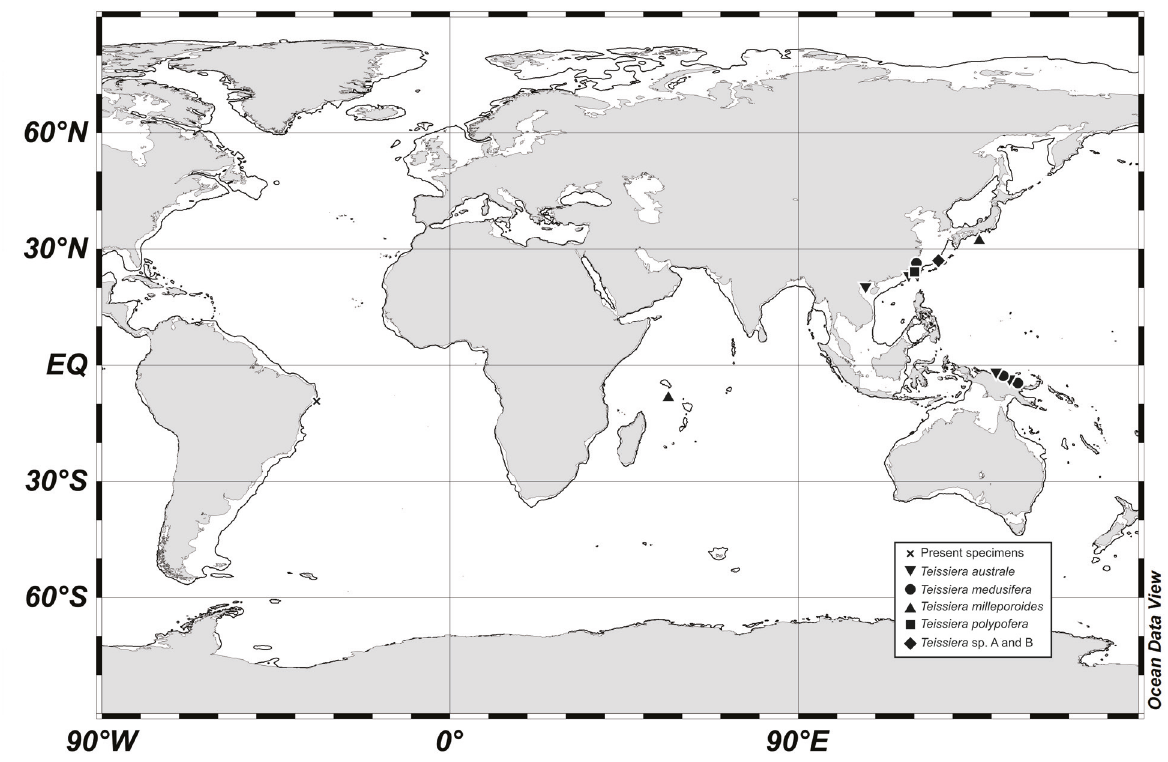
Figure 2. Global distribution of Teissiera species based on this study and literature records (Bouillon 1974, 1978, Xu et al. 1991, Xu & Huang 2004, Kubota 2006, Li et al. 2006, Kubota & Gravili 2007, Du et al. 2012). The dashed line shows the 250 m isobath, roughly corresponding to the shelf break. Generated using Ocean Data View software (Schlitzer